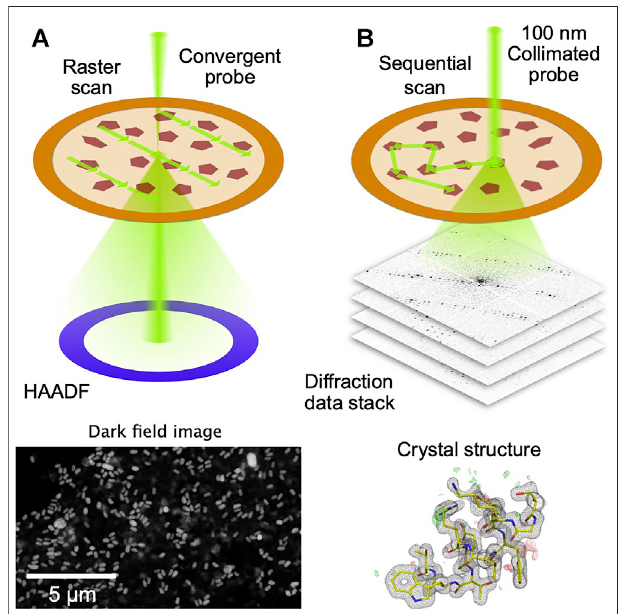
FIGURE 1 | Principle of STEM-based SerialED. (A) A low-resolution, low-dose STEM image is taken over a large region on a TEM grid. Signal is generated using the high-angle dark fi eld (HAADF) detector (B) After the crystalshavebeenidenti fi edintheSTEMimage,thebeamissequentially steered to each autmatically found crystal. A fast detector records the diffraction patterns in a synchronized way. From the diffraction data, the crystal structure is